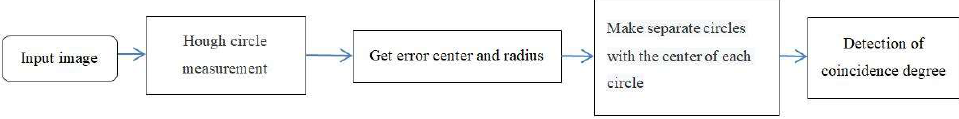
Figure 11. Algorithm flow chart.